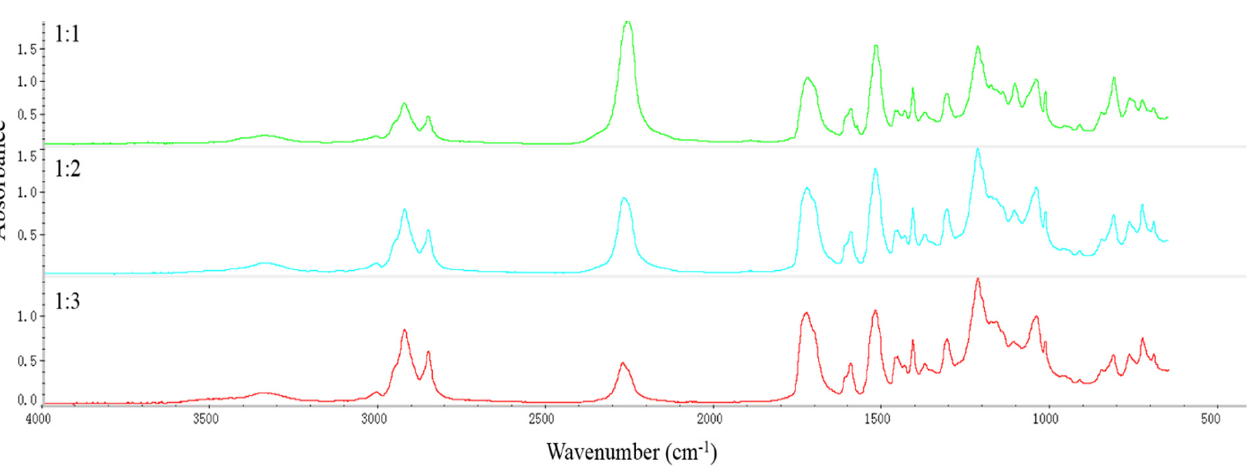
Table 3. Orthogonal test results for tensile strength and various factors of polyurethane